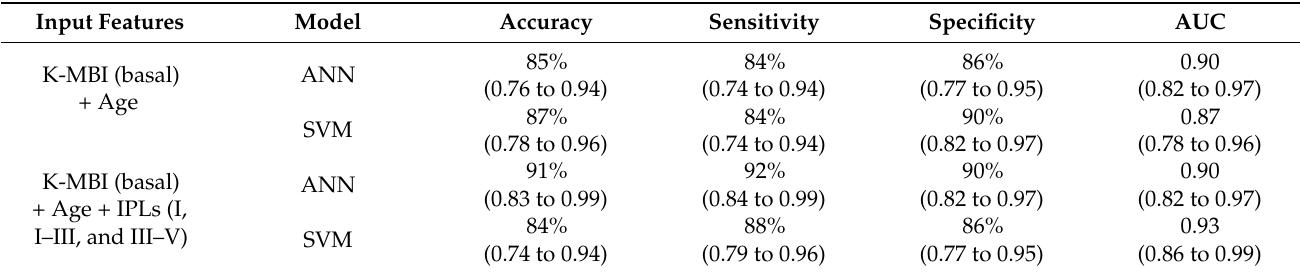
Table 6. Test results in prediction of favorable and unfavorable outcomes.